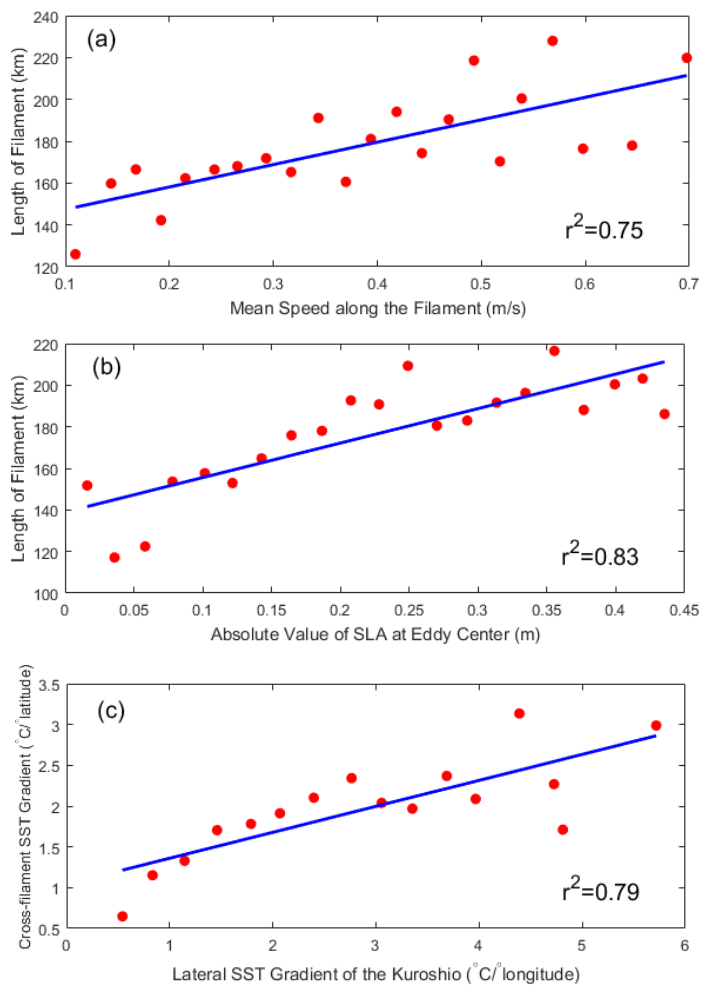
Figure 9. Scatterplots of ( a ) mean speed along the filament versus length of filament, ( b ) absolute value of SLA at eddy center versus length of filament and ( c ) lateral SST gradient of the Kuroshio versus SST gradient across the filament, each with best fit linear